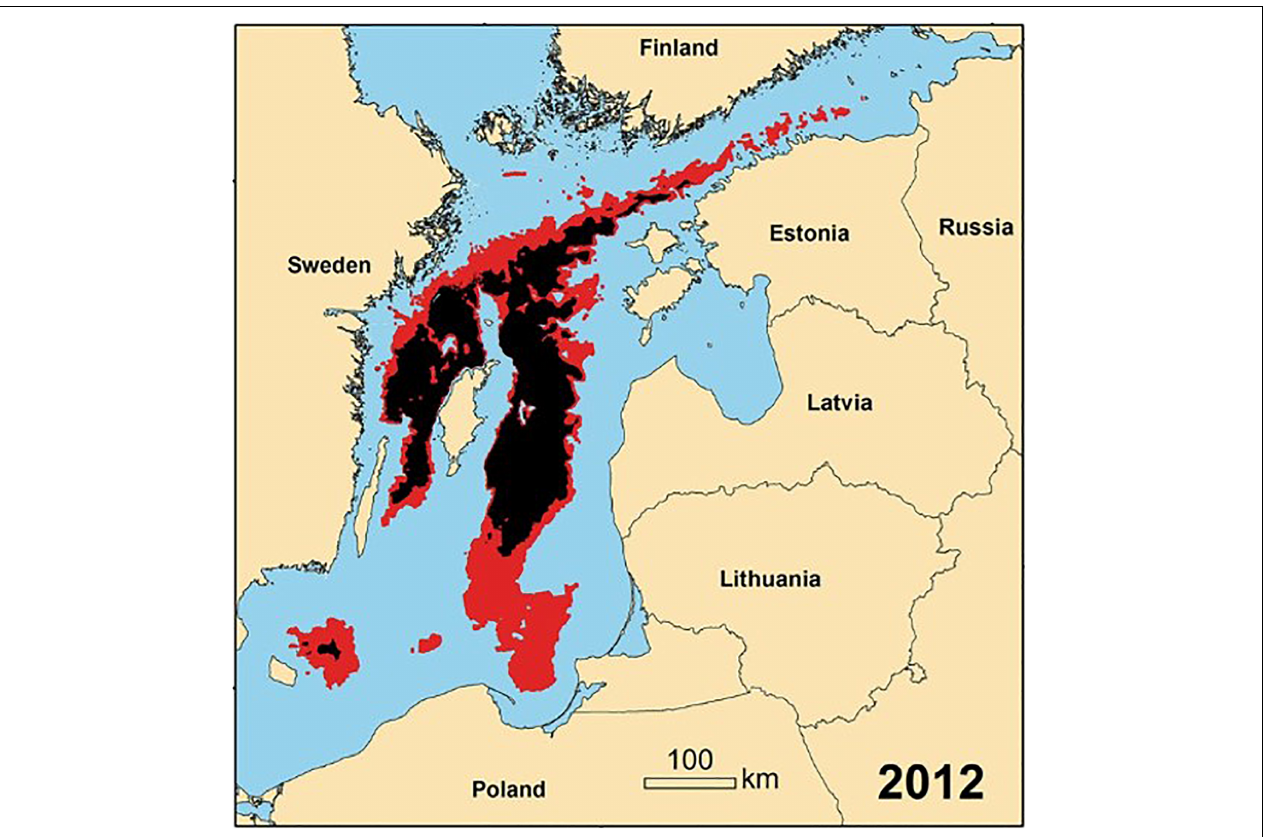
FIGURE 5 | Spatial distribution of bottom hypoxia (red) and anoxia (black) in the Baltic Sea in 2012 (annual mean modified from Carstensen et al., 2014).